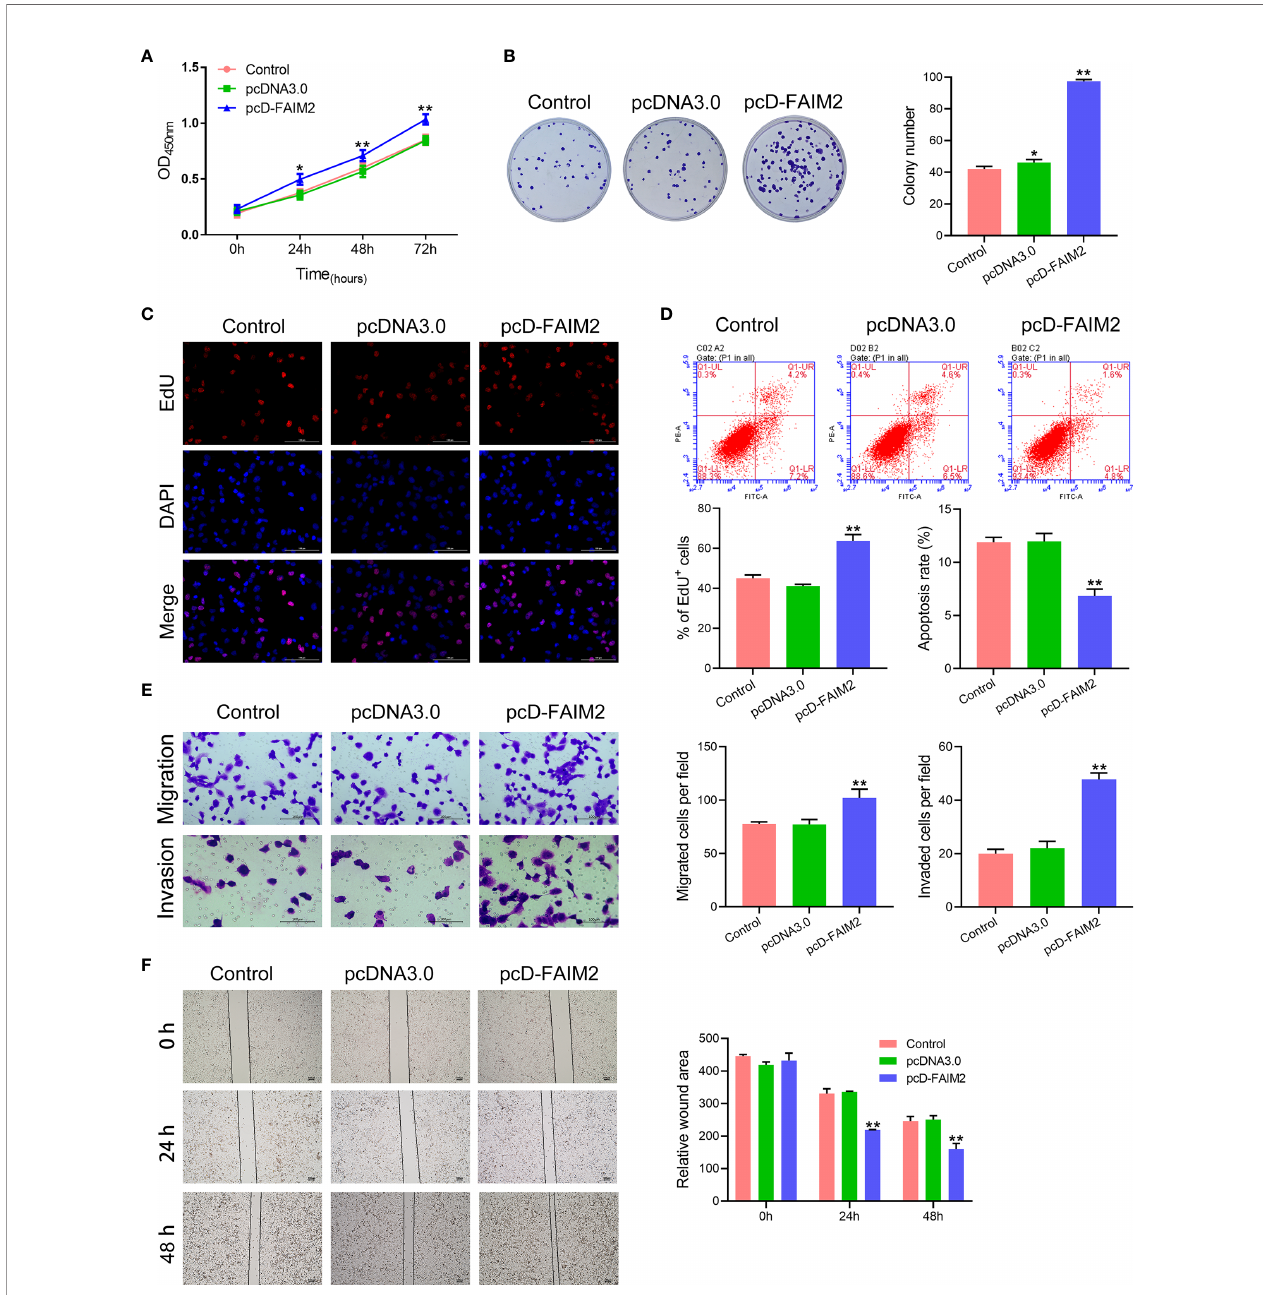
FIGURE 3 | Upregulation of FAIM2 promoted HARA cell proliferation, migration, and invasion, but reduced cell apoptosis. Following pcDNA3.0 or pcD-FAIM2 transfection, (A) the viability of HARA cells was detected via the CCK-8 assay. (B, C) HARA cell proliferation was evaluated via the colony formation assay and EdU staining. (D) HARA cell apoptosis was assessed by fl ow cytometry. (E) HARA cell migration and invasion were measured via the two-chamber Transwell assay. (F) The cell scratch assay was conducted to further test for HARA cell migration. P < 0.05, *; P < 0.01, ** vs. the pcDNA3.0